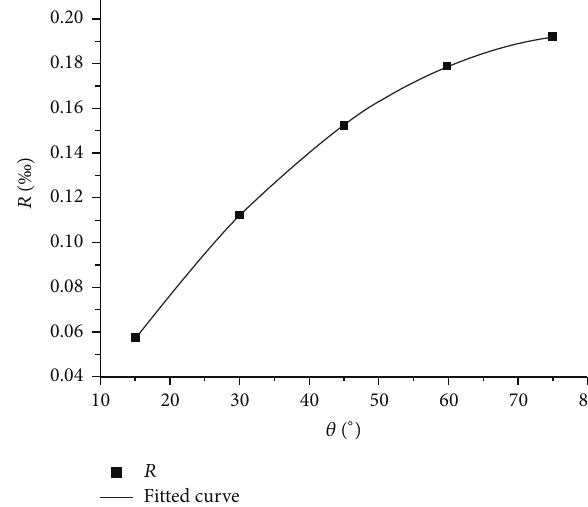
Figure 12: Axial strain at peak strength versus crack orientations.